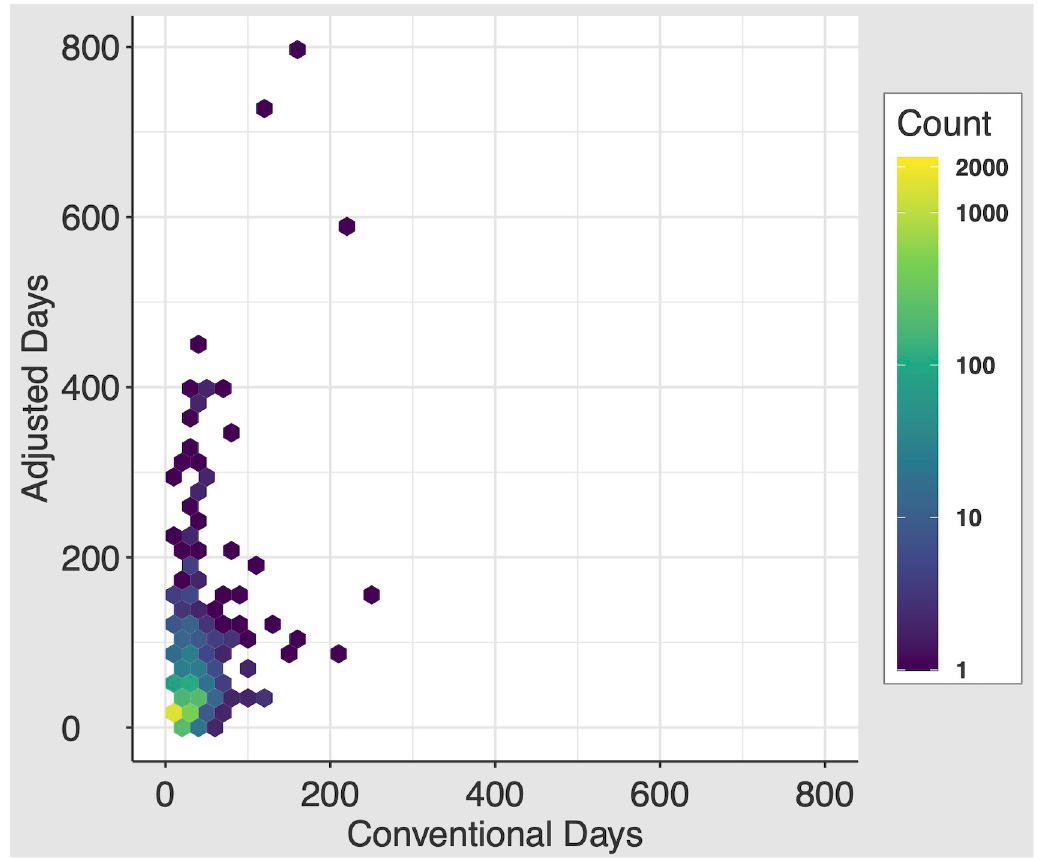
Fig 2. Distribution of the conventional days and adjusted days metrics. 2D histogram, with each equally-sized hexbin’s color demonstrating the concentration of patients in that bin.